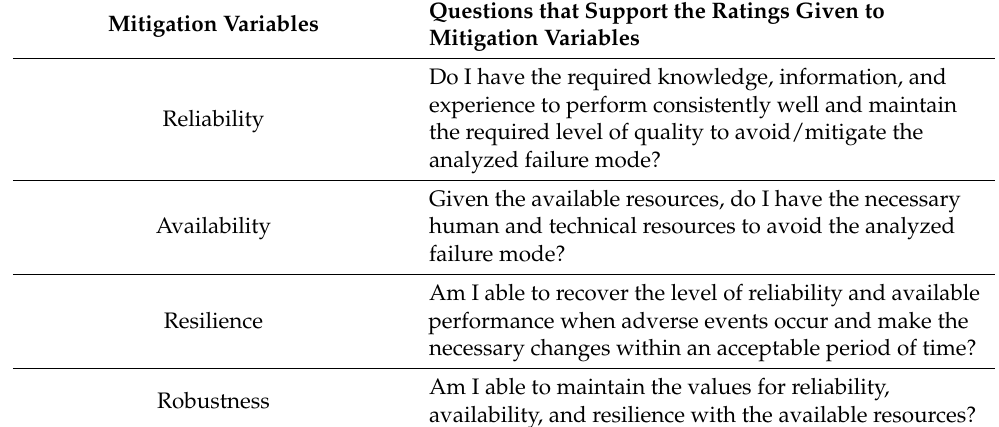
Table 1. Questions to rate mitigation variables.